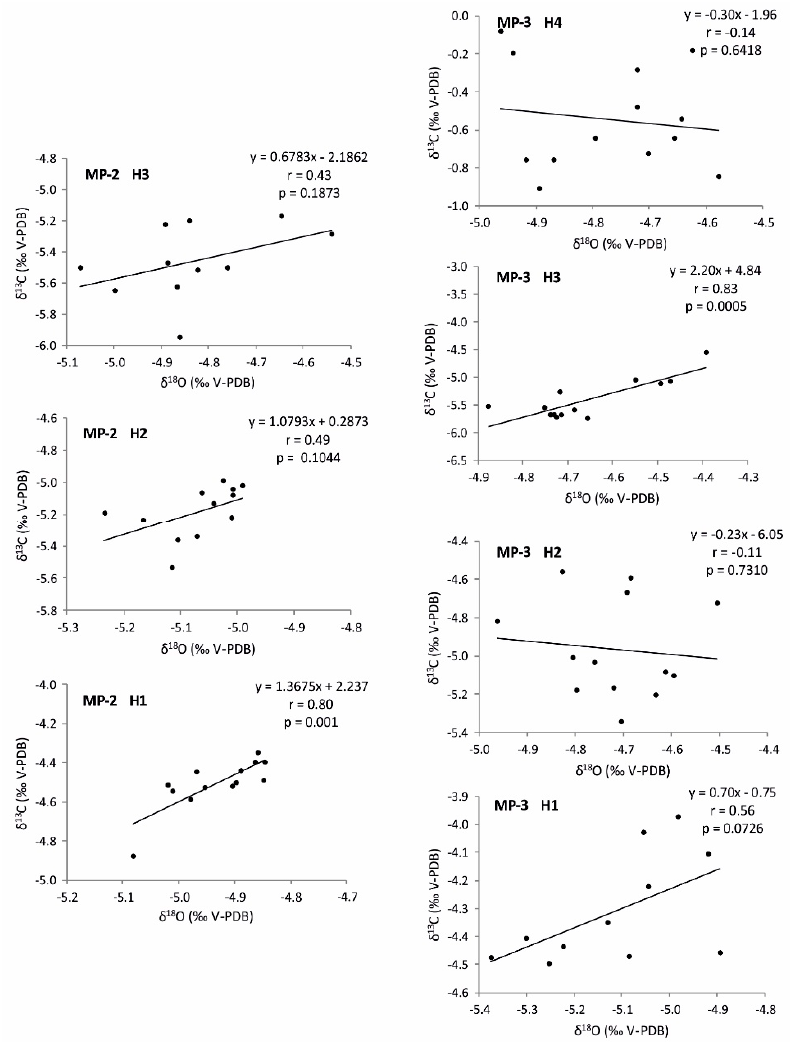
Figure A2. Plots of δ 18 O– δ 13 C pairs from single growth layers in MP-2 (left column) and MP-3 (right column) stalagmites. For the location of the sampling tracks, see Figure 2.